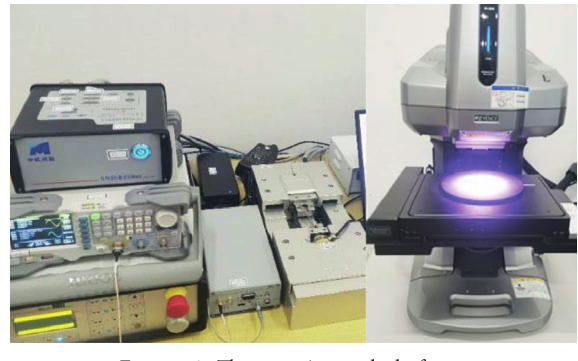
Figure 3: The experimental platform.